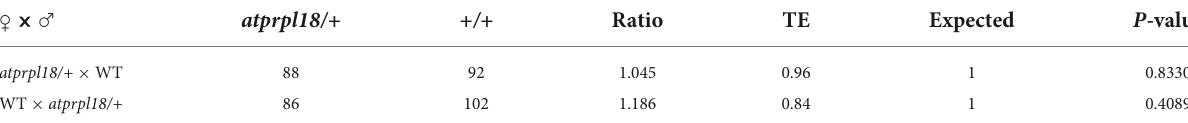
TABLE 1 The gamete transmission efficiency of atprpl18/+ mutant.